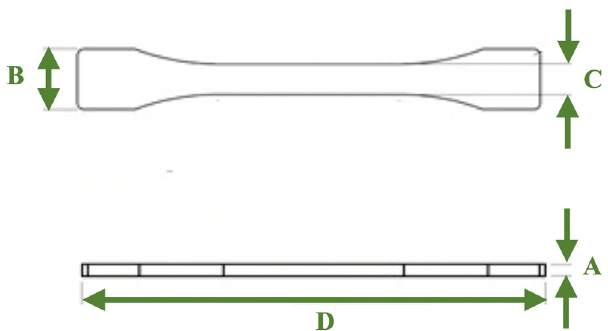
Figure 3. Measured dimensions in dog bones of group 1. ( A ) thickness of the middle, ( B ) width of one side, ( C ) width of the center, ( D ) length of the dog bones.